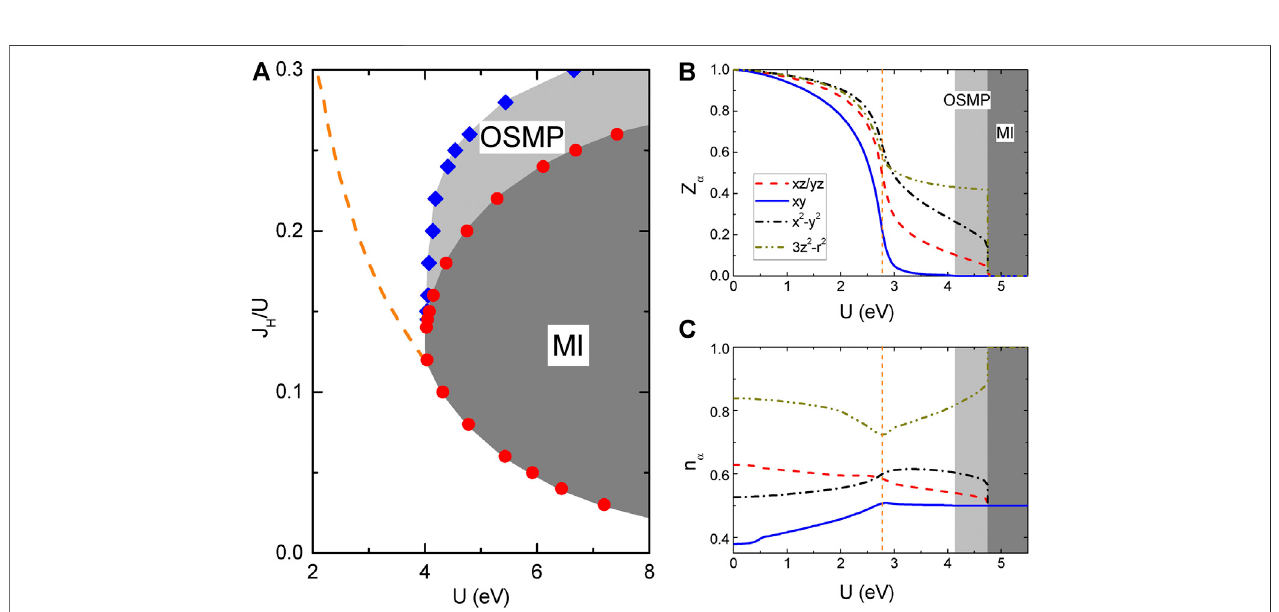
FIGURE 2 | (A) Ground-state phase diagram of the fi ve-orbital multiorbital model for alkaline iron selenides at commensurate fi lling n (cid:2) 6. The dark and light gray regionscorrespondtotheMIandOSMP,respectively.Theorangedashedlinereferstoacrossoverbetweentheweaklycorrelatedmetal(WCM)andbadmetal(strongly correlated metal, SCM). (B) and (C) The evolution of the orbital resolved quasiparticle spectral weights [in (B) ] and electron fi lling factor per spin [in (C) ] with U in the fi ve-orbital model at J / U (cid:2) 0 . 2, adapted from [62]. H